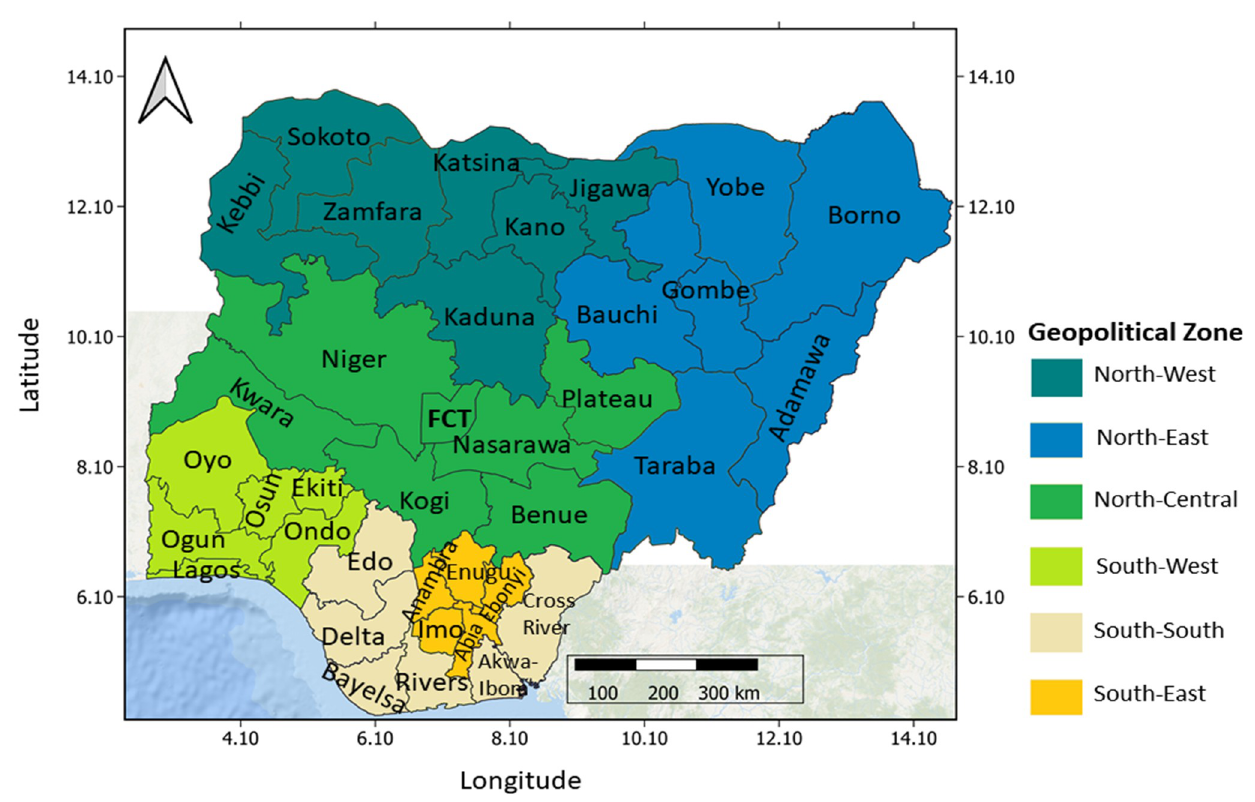
Fig 1. Map of Nigeria showing the 36 states and the FCT and the six (6) geopolitical zones. Shapefile republished from DIVA-GIS database (https:// www.diva-gis.org/) under a CC BY license, with permission from Global Administrative Areas (GADM), original copyright 2018.